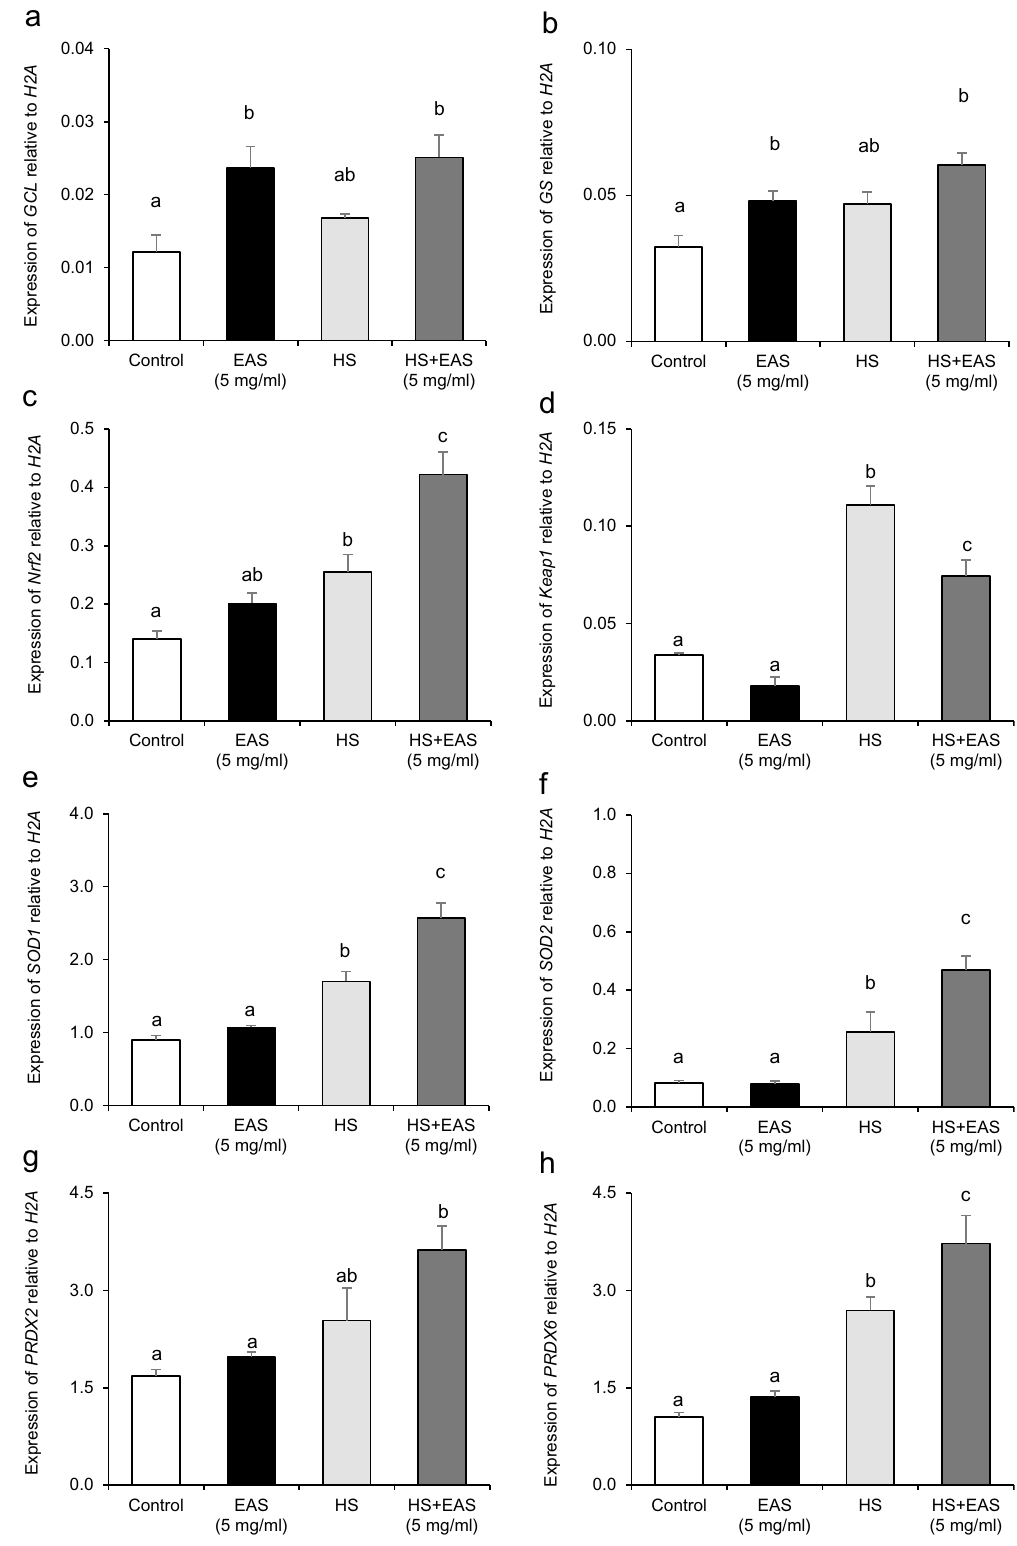
Figure 7. Effect of EAS on expressions of GS, GCL, Nrf2, Keap1, SOD1, SOD2, PRDX2 and PRDX6 under non- and HS conditions. Cells were treated for 6 h with or without EAS (5 mg/ml) under normal conditions at 38.5 °C (control, EAS group) and HS conditions at 41 °C (HS, HS + EAS group). The expression levels of GS, GCL, Nrf2, Keap1, SOD1, SOD2, PRDX2 , and PRDX6 were examined using real-time quantitative PCR normalized to H2AFZ as a reference gene. ( a ) GCL , ( b ) GS , ( c ) Nrf2 , ( d ) Keap1 , ( e ) SOD1 , ( f ) SOD2 , ( g ) PRDX2 , ( h ) PRDX6 . Data are shown as the mean ± SEM, n = 5; means with different letters ( a – c ) at each mRNA is significantly different ( P <